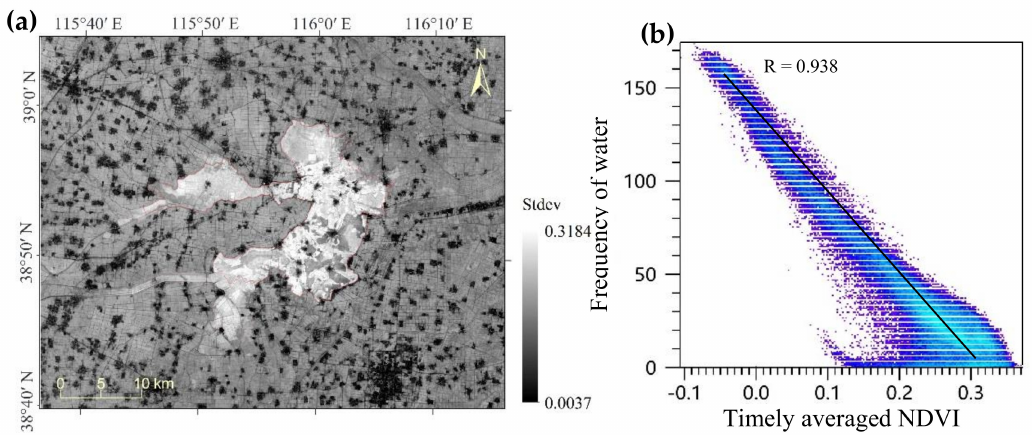
Figure 9. Interacting changes of aquatic vegetations and water in wetland, ( a ) The standard deviation (Stdev) of NDVI time-series data from 1984 to 2017; ( b ) Histogram of time averaged NDVI and the cumulative frequency of open water from 1984 to 2017 for the pixels within the wetland range of 2017, where the gradient colors from blue to cyan mean the number of pixels within the wetland from the least to the